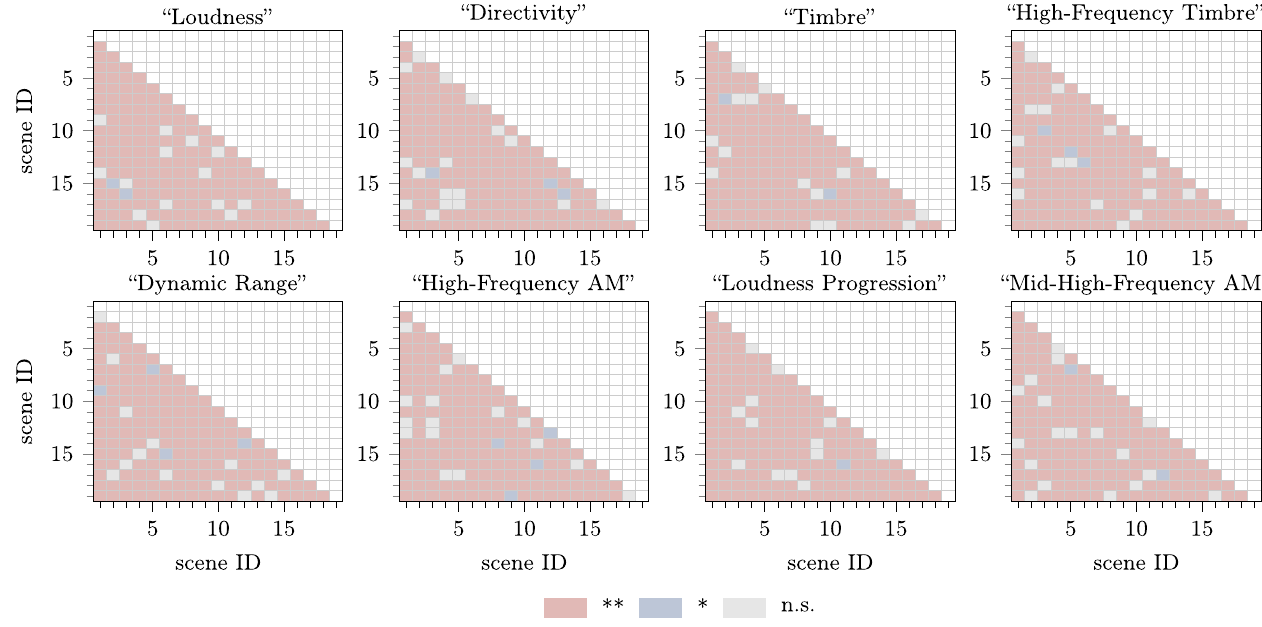
Figure 4. Statistical di ff erences between sample soundscapes. Red: strong signi fi cance ( p < 0.01), blue: moderate signi fi cance ( p < 0.05), gray: no signi fi cance ( p >